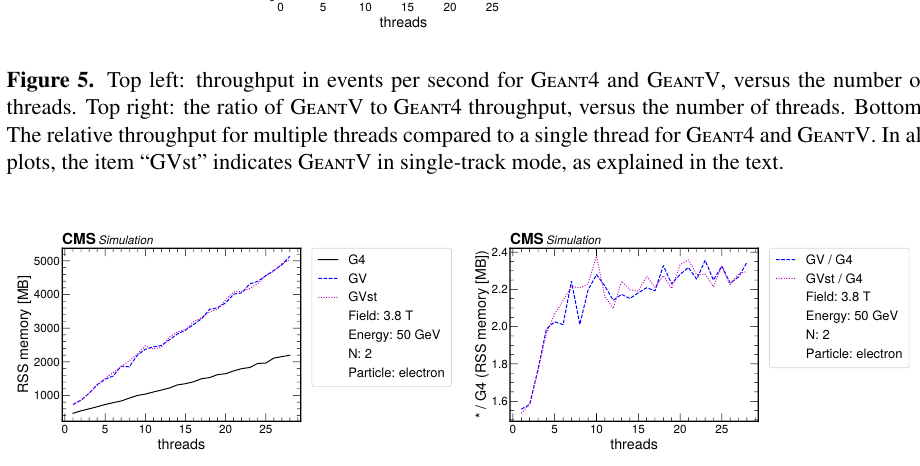
Figure 6. Left: RSS memory in MB for G eant 4 and G eant V, versus the number of threads. Right: the ratio of G eant V to G eant 4 RSS memory, versus the number of threads. In all plots, the item “GVst” indicates G eant V in single-track mode, as explained in the